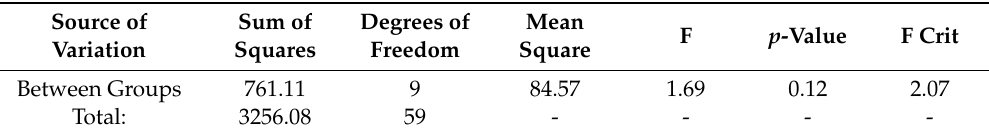
Table 11. One-way analysis of variance (ANOVA) test for statistical significance between all examined implant materials and associated average infection